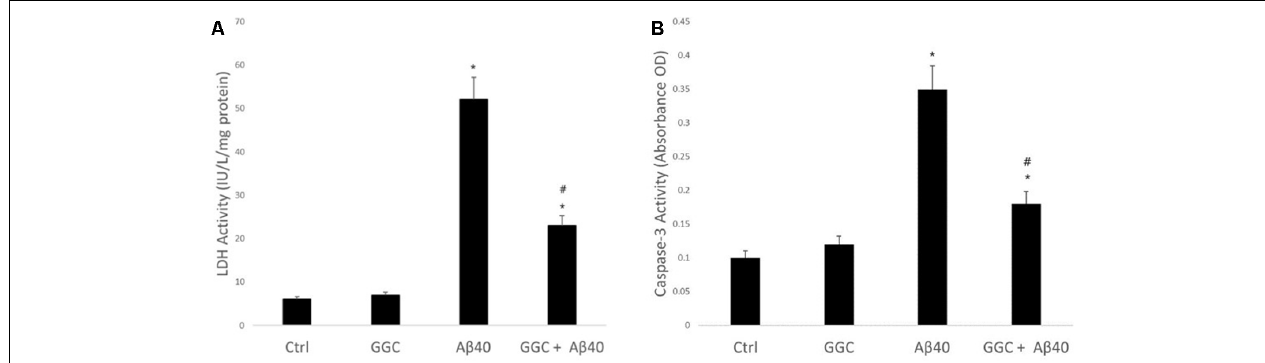
FIGURE 1 | Neurotoxic effect of oligomeric A β 40 in isolated adult astrocytes can be ameliorated using GGC. (A) A β 40 significantly decreased astrocyte cell viability. Treatment with GGC (200 mM) provided significant protection from exposure to oligomeric A β 40 . (B) Treatment of astrocytes with GGC significantly reduced caspase